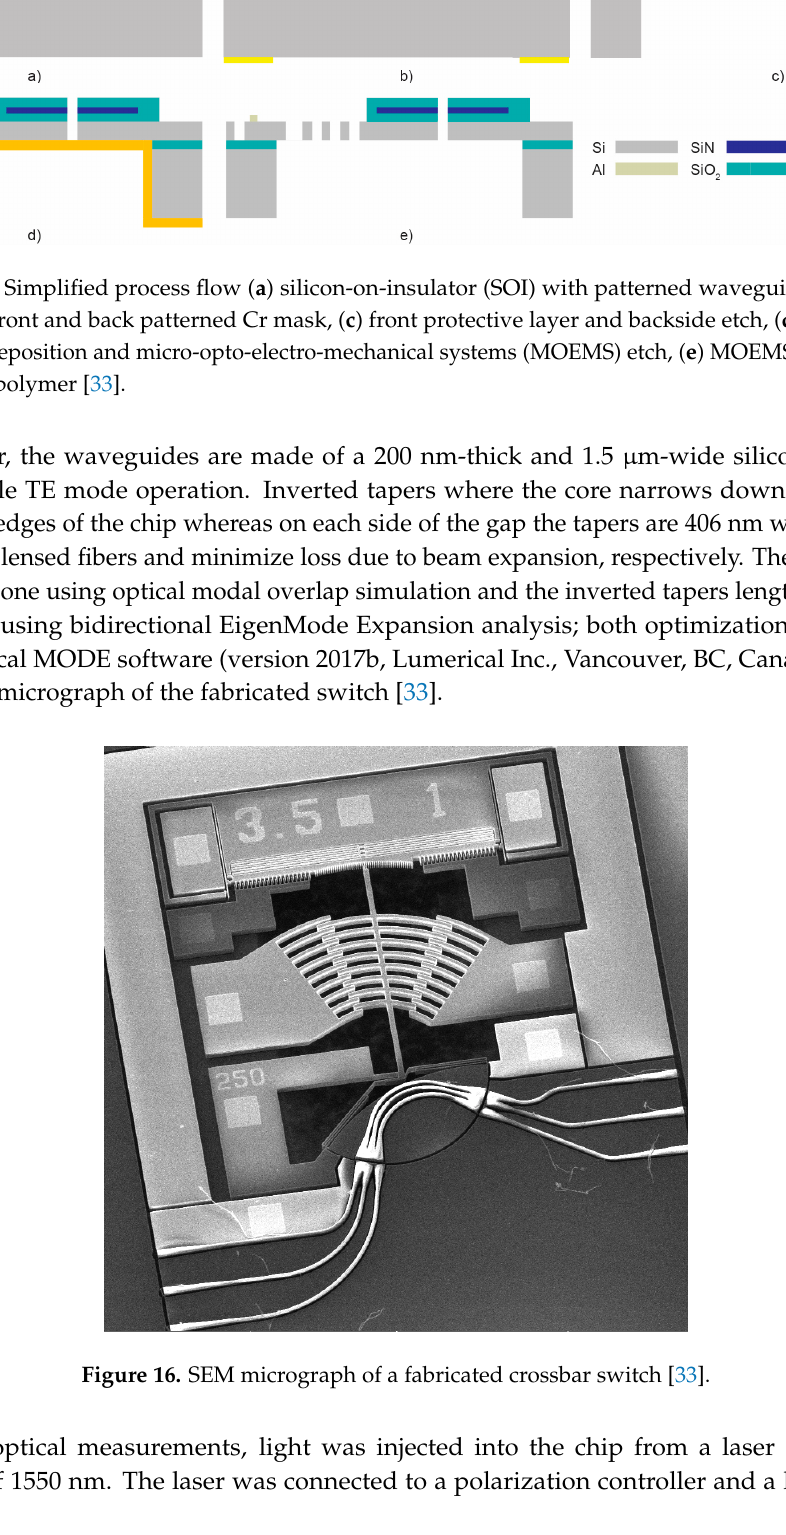
Figure 16. SEM micrograph of a fabricated crossbar switch [33].